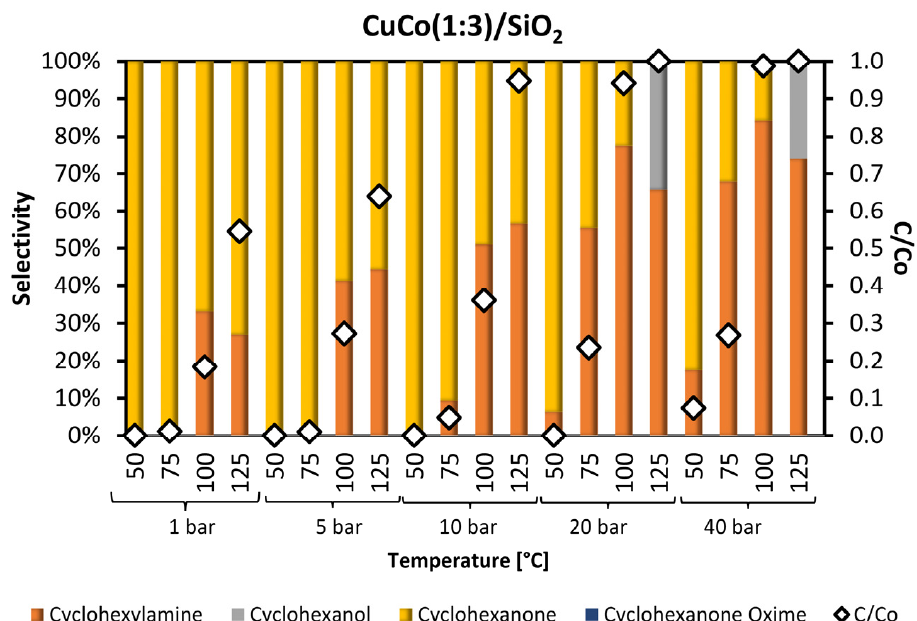
Figure 11. Catalytic hydrogenation of nitrocyclohexane in liquid flow conditions with CuCo(1:3)/SiO 2 .